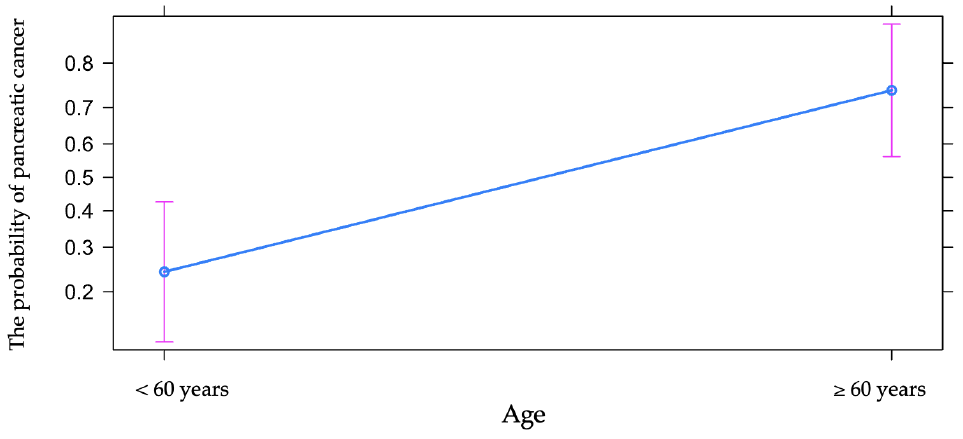
Figure 4. The influence of age on the risk of pancreatic cancer.